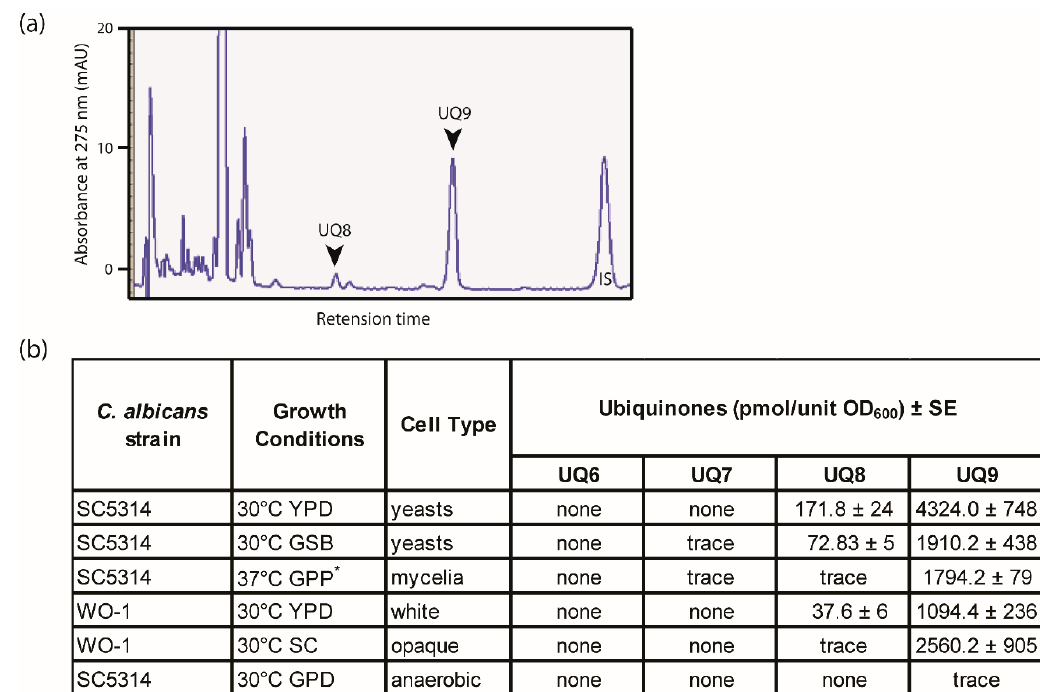
Figure 2. Ubiquinone analysis in physiologically distinct C. albicans morphological types. The analysis was undertaken by high-performance liquid chromatography (HPLC) in diode array detection (DAD) mode using UQ10 as the internal standard (IS) [21]. ( a ) Representative histogram from ubiquinone profile of C. albicans cells grown in synthetic (glucose-salts-biotin, GSB) medium. ( b ) Quantification of ubiquinones as detected by HPLC-DAD. Trace indicates that the ubiquinone detected was below the sensitivity limit of 0.1 pmol unit − 1 OD600 nm. * Glucose-proline-phosphate (GPP) medium is supplemented with N-acetylglucosamine as an inducer of hyphal growth. GPD is the defined medium developed by Dumitru et al. [27] for anaerobic growth of C. albicans . Data are means ± standard deviation (SD) of duplicate measurements.